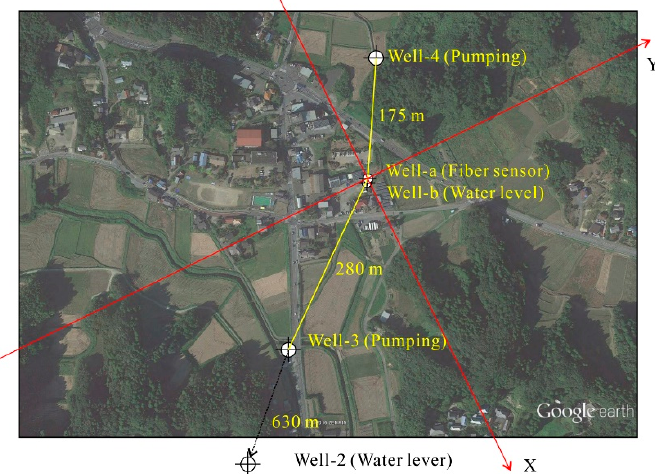
Figure 2. Map of the test site and configuration of wells for pumping, fiber sensor monitoring, and water head measurement.